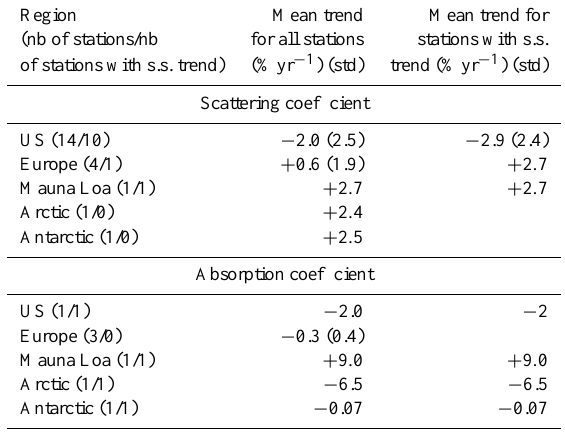
Table 8. Overview of scattering and absorption decadal (2001– 2010) trends per continent/region of the world. Region Mean trend Mean trend for (nb of stations/nb for all stations stations with s.s. of stations with s.s.